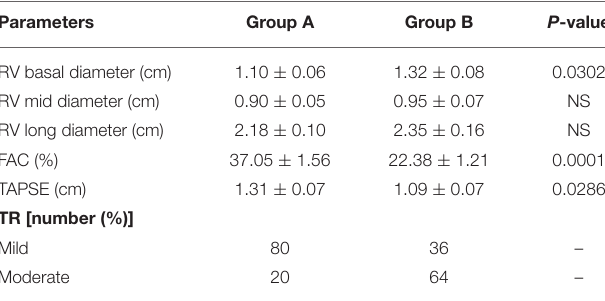
TABLE 4 | Comparison between the two groups regarding right ventricular echocardiographic